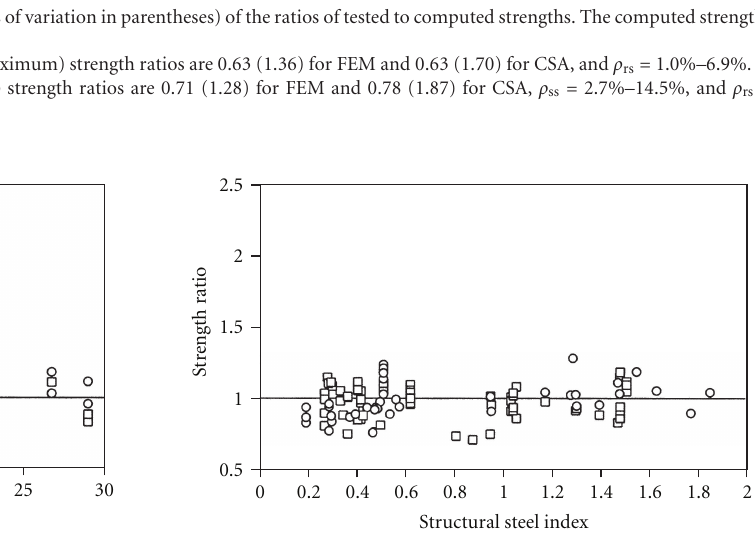
Figure 13: E ff ect of structural steel index ρ ss f yss / f (cid:2) c on FEM strength ratios for composite columns ( n =